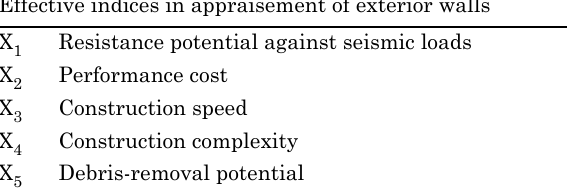
Table 3. appraisement indices of all types of exterior